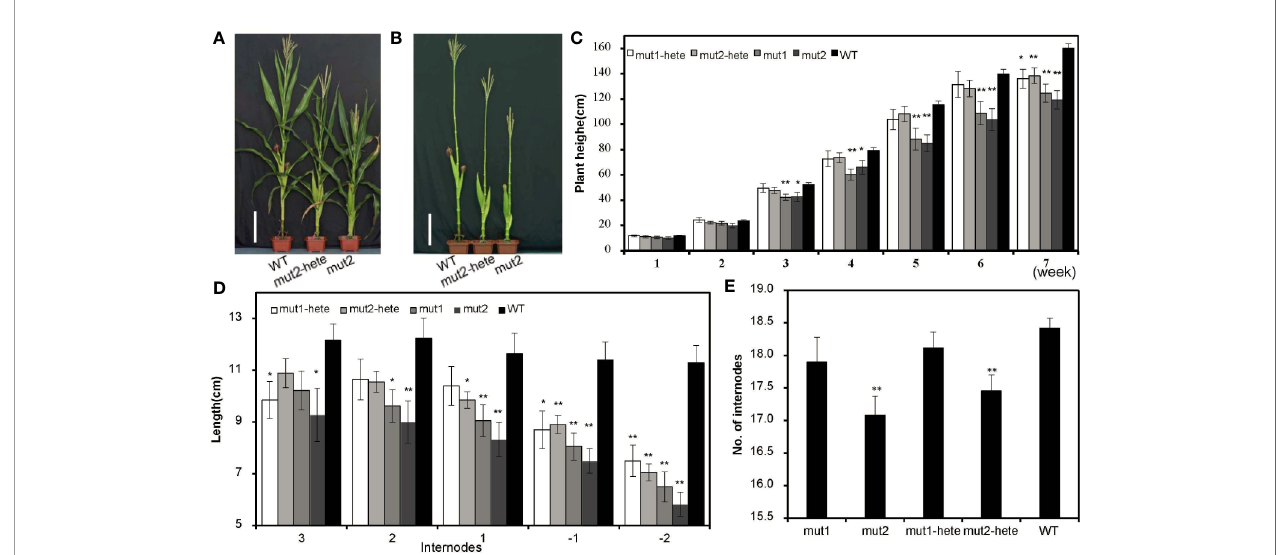
FIGURE 2 | Plant height and internodes of the mutant plants. (A, B) Plant height of mut2 and wild-type plants at the mature stage. Plant leaves were stripped (B) or not (A) . Scale bar = 25 cm. (C) Plant height of mutant plants at different development stages. The values shown are the average ± S. E. for independent plants (number of mut1-hete =11, number of mut2-hete = 18, number of mut1 = 13, number of mut2 = 12, number of WT = 68) (D) The internode lengths of the mutant and WT plants. The internodes above the ear are labeled 1, 2, and 3, and the internodes below the ear are labeled -1 and -2. The values shown are the average ± S. E. for independent plants (number of mut1-hete =10, number of mut2-hete = 10, number of mut1 = 9, number of mut2 = 19, number of WT = 10). (E) The numbers of internodes in mutant and WT plants. Error bars represent the standard errors of nine biological repeats. The values shown are the average ± S. E. for independent plants (number of mut1-hete =10, number of mut2-hete = 10, number of mut1 = 9, number of mut2 = 9, number of WT =10). * indicates a signi fi cant difference at the P < 0.05 level, and ** indicates a signi fi cant difference at the P < 0.01